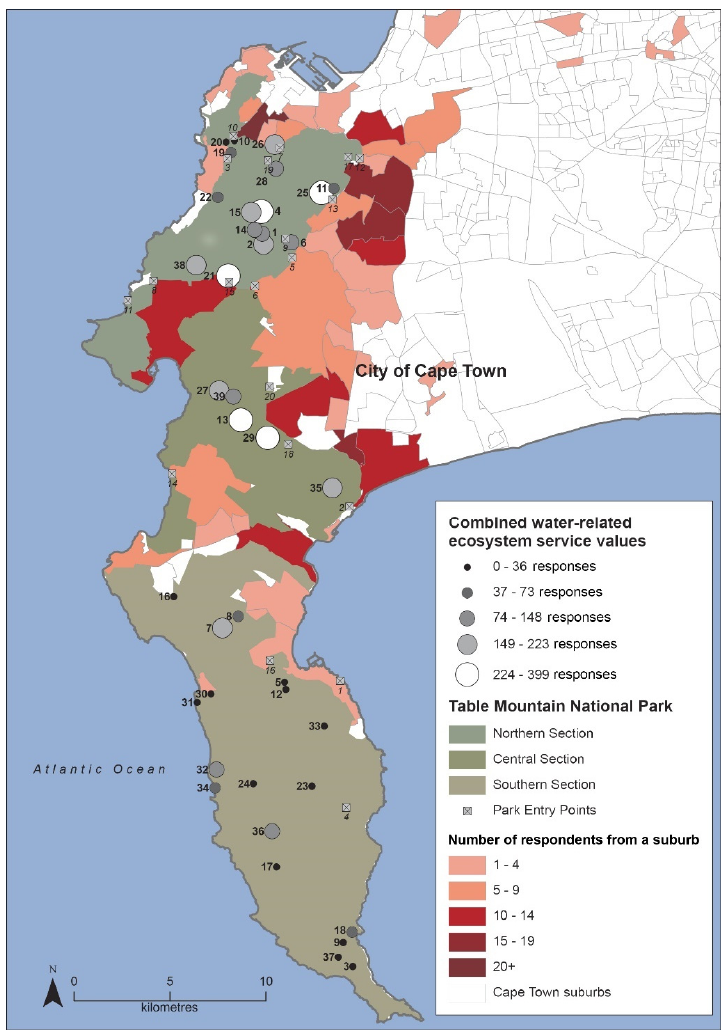
Figure 2. Combined total cultural ecosystem service responses by users of the Table Mountain National Park freshwater features. Water features are numbered from 1 to 39 and relate to Table A4 (Appendix F). The numbered crossed boxes refer to park entry points. Park entry points and numbered water features are listed in Tables A1 and A2, respectively. Suburbs are color-coded according to the number of survey participants residing there.